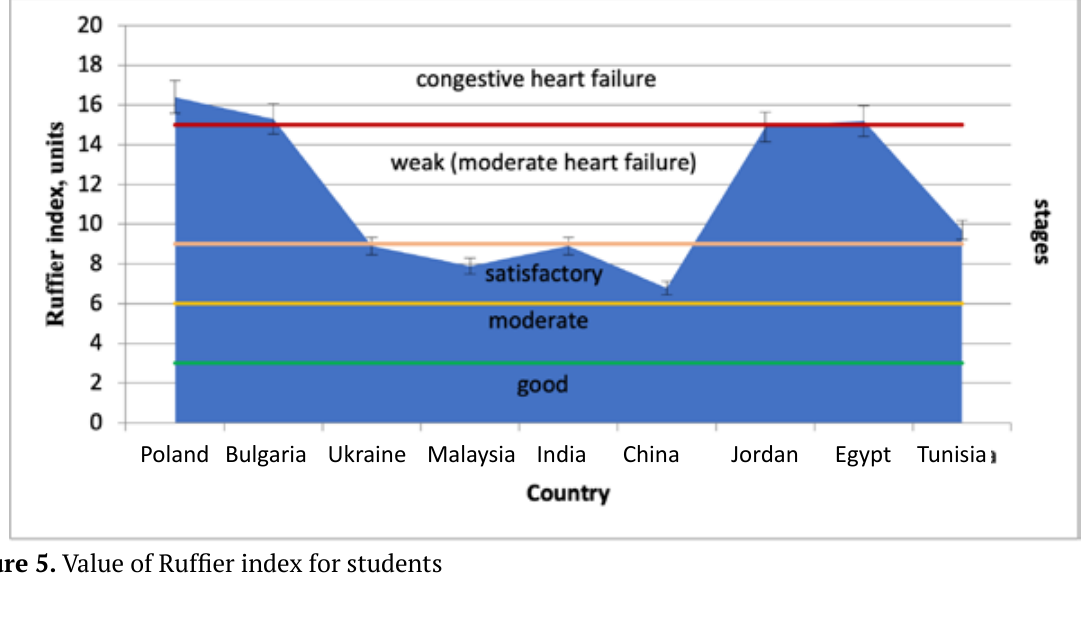
Figure 5. Value of Ruffier index for students